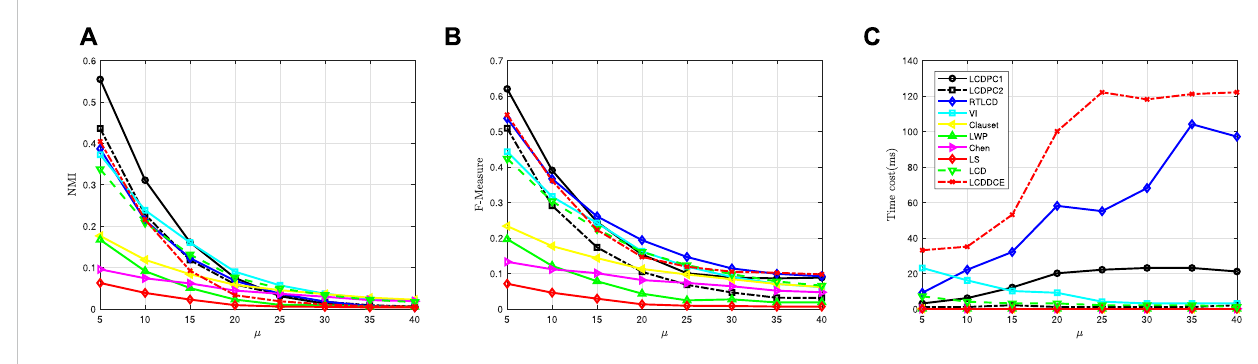
FIGURE 6 The performance of algorithms on LFR- μ . (A) NMI on LFR- μ . (B) F-measure on LFR- μ . (C) Time cost on LFR- μ